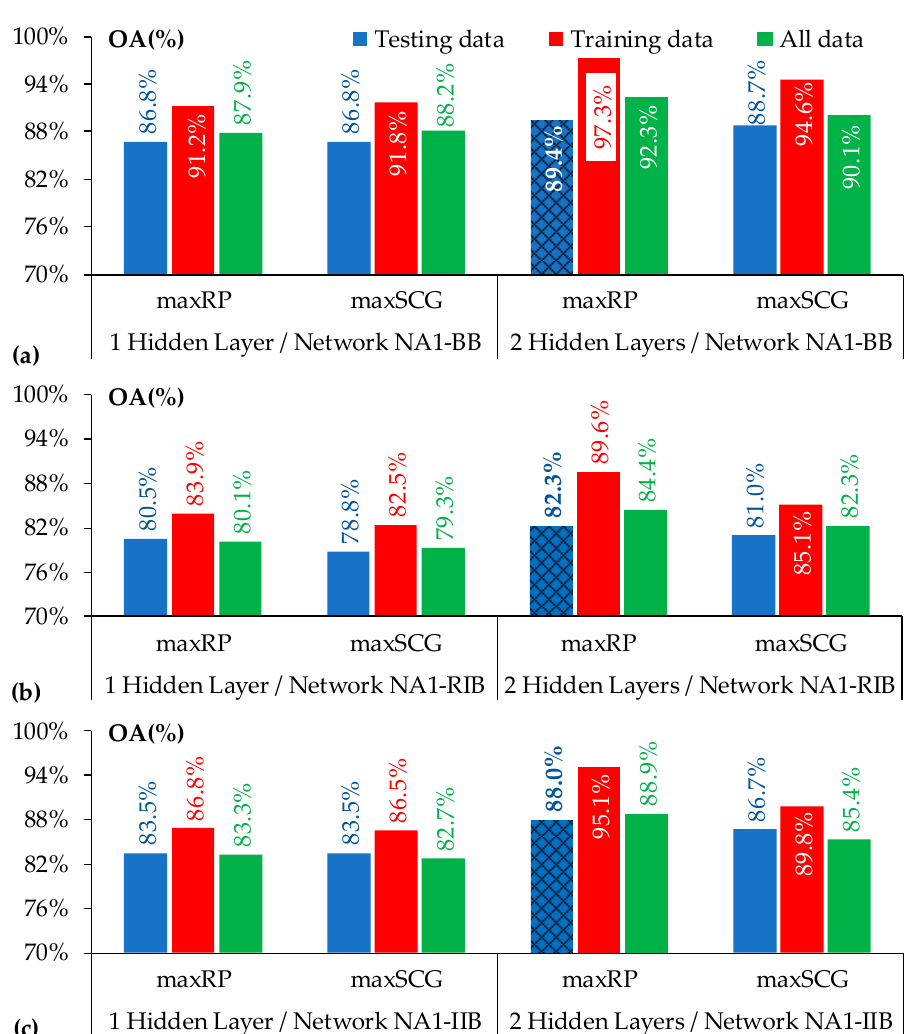
Figure 7. Maximum OA index values extracted by NA1 networks with 1 or 2 hidden layers: ( a ) BB; ( b ) RIB; ( c ) IIB.